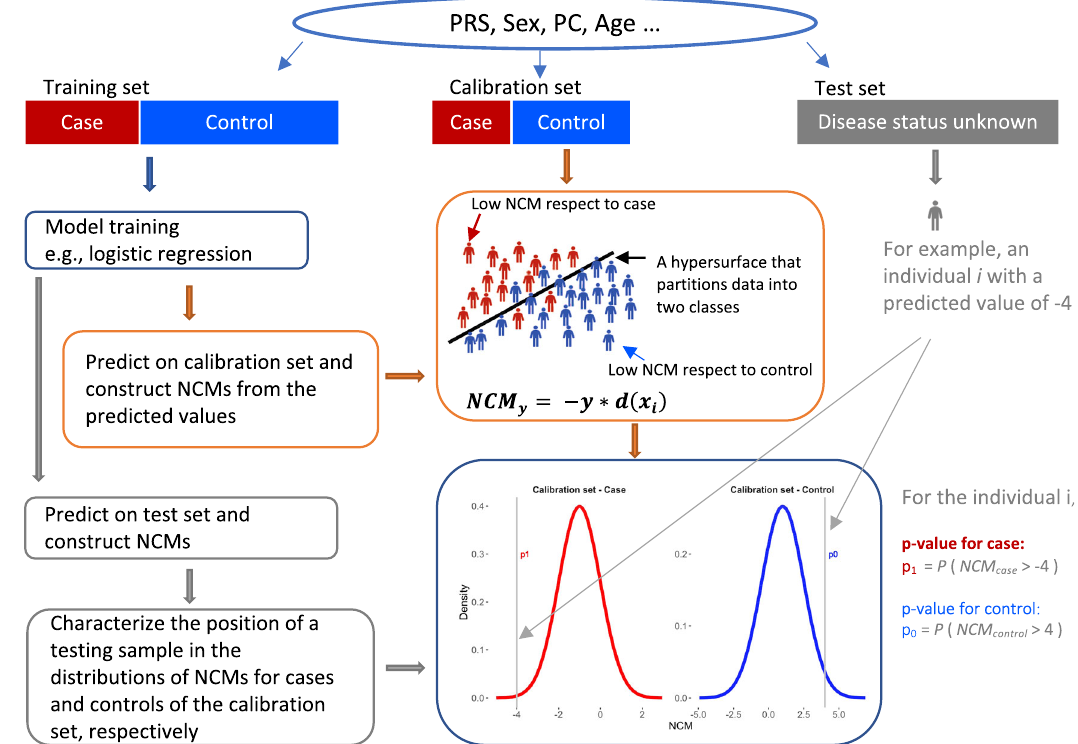
Fig. 1 Schema of the MCCP for the PRS-to-trait prediction. Using summary statistics from a reference GWAS, PRS is obtained for the target population. The calibration set includes individuals with known disease status. A model is built on the training set and nonconformity measures (NCM) can be computed for both calibration and test sets, respectively. The NCMs distributions in the calibration set are obtained for case and control, respectively (blue and red curves). The MCCP probability values for an individual to be the case ( p 1 ) or control ( p 0 ) (gray vertical bar) are estimated, respectively. In principle, population structures, age, sex, and other covariates can also be added to the model to increase its